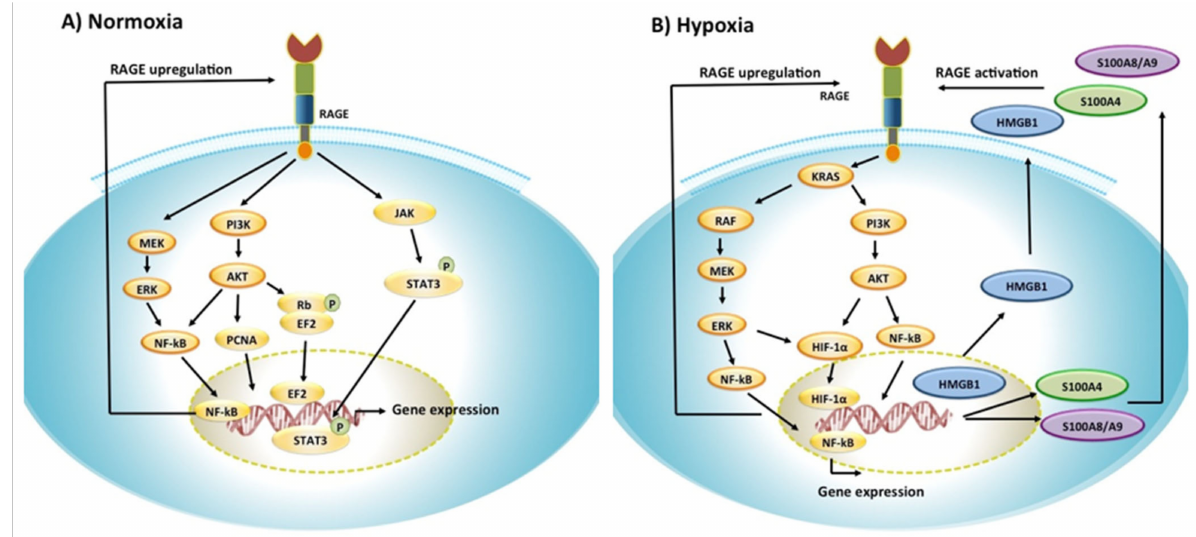
Figure 3. RAGE signaling pathways in normoxia and hypoxia. ( A ) In normoxia, RAGE activation by its ligands results in the activation of the MEK/ERK, PI3K/Akt, and JAK/STAT pathways, resulting in gene expression through the activation of NF-kB and STAT3. Because the expression of RAGE is under the control of NF-kB, RAGE activation results in RAGE upregulation through positive feedback. ( B ) In hypoxia, RAGE activation has been shown to stimulate HIF-1 α through the activation of the PI3K/Akt and the RAS/RAF/MEK/ERK pathways. In hypoxia, nuclear HMGB1 translocates to the extracellular space through an unknown mechanism and interacts with RAGE. S100A4 and S100A8/A9 are upregulated and secreted in the tumor microenvironment and interact with RAGE. RAGE interaction with HMGB1, S100A4, and S100A8/A9 results in the activation of the MEK/ERK and PI3K/Akt pathways, resulting in changes in cancer-related gene expressions through the activation of NF-kB. NF-kB can further induce HIF-1a